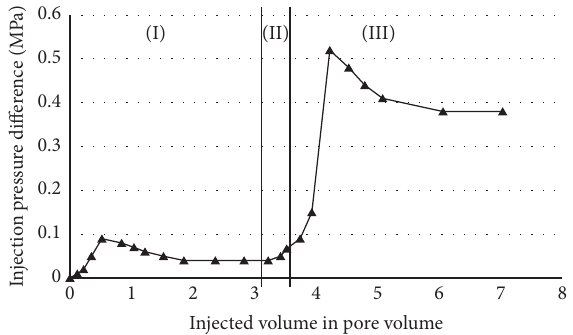
Figure 9: Injection pressure difference curves ((I) water injection, (II) weak gel injection, and (III) water injection).